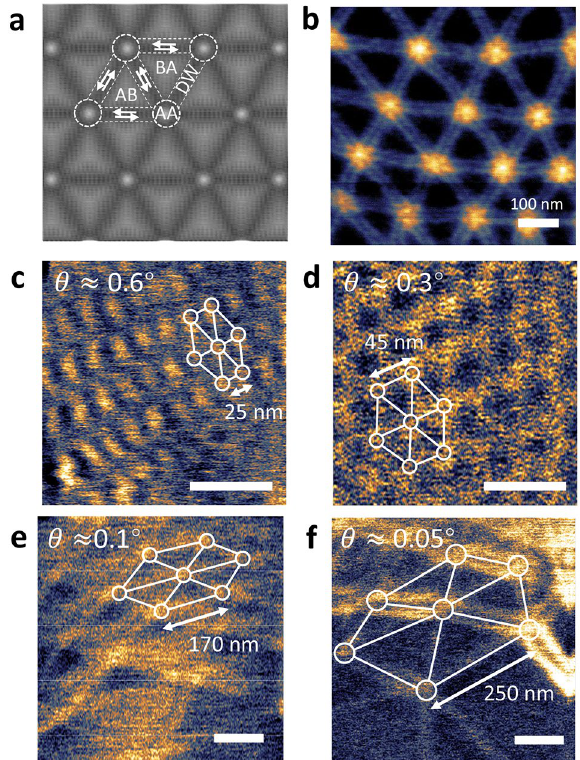
Figure 4. Tuning the moiré period through fine adjustment of the twist angle. ( a ) Schematic of twisted bilayer graphene after atomic reconstruction. ( b ) Near-field infrared image of a typical twist bilayer graphene at high doping level. ( c – f ) A series of near-field infrared images of a twistable device at slightly different twist angles, showing a systematically increase of the moiré period. This is achieved by fine tuning of the twist angle using AFM tip. Scale bar: 100